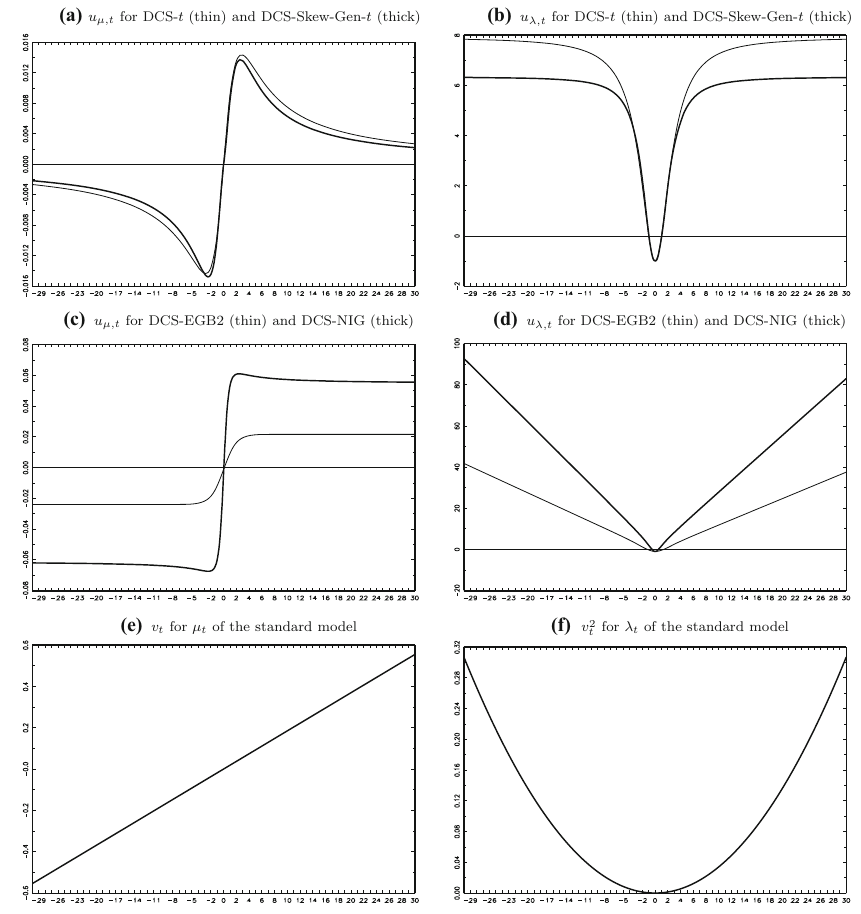
Fig.2 Updating terms for DCS and standard financial time series models; estimated for the GTQ/USD time series. Notes Each updating term is presented as a function of the error term (cid:3)